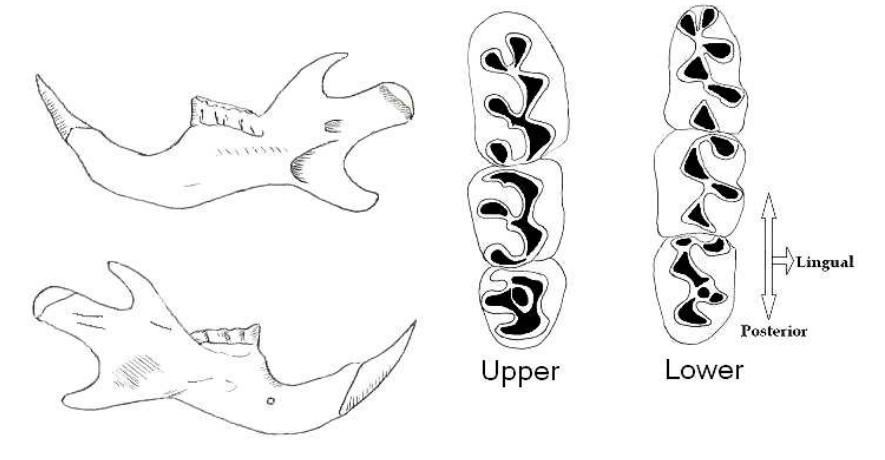
FIGURE 8 : Mandibles and teeth rows in Cricetulus